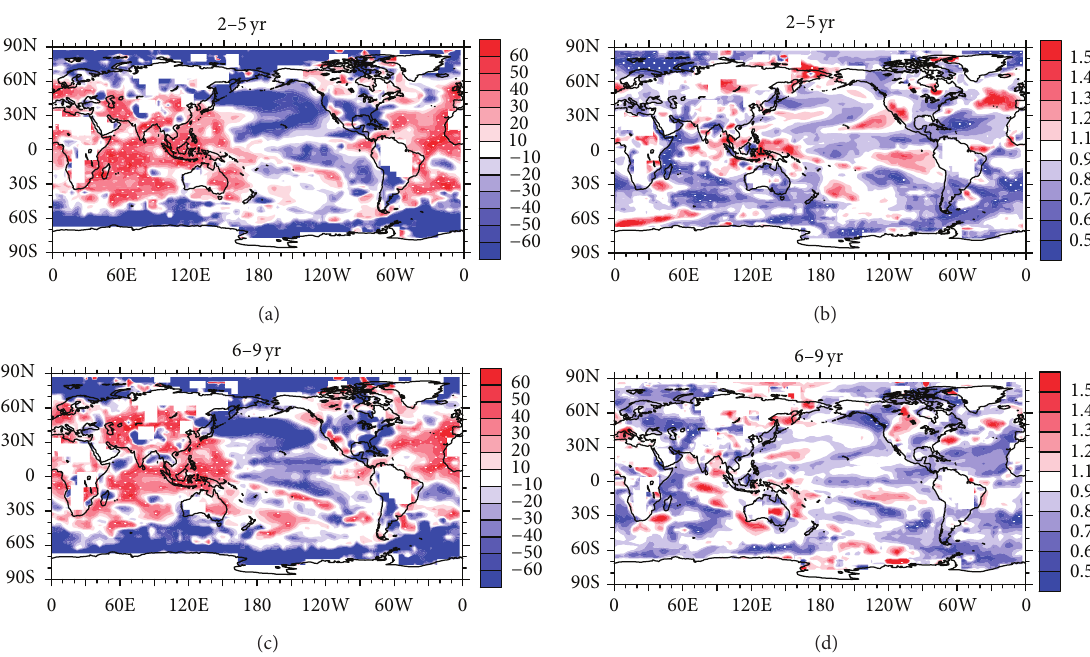
Figure 1: Forecast qualities of near-surface air temperature. (a) RMSSS (multiplied by 100) of the ensemble mean of the INIT runs for predictions averaged over the hindcast years 2–5. The white dots represent that the skill scores at these points are statistically significant at the 15% level based on the one-sided 𝐹 test. (b) Ratio of RMSE between the ensemble mean of the INIT runs and that of the NoINIT runs for predictions averaged over the hindcast years 2–5. ((c), (d)) The same as (a) and (b) but for the years